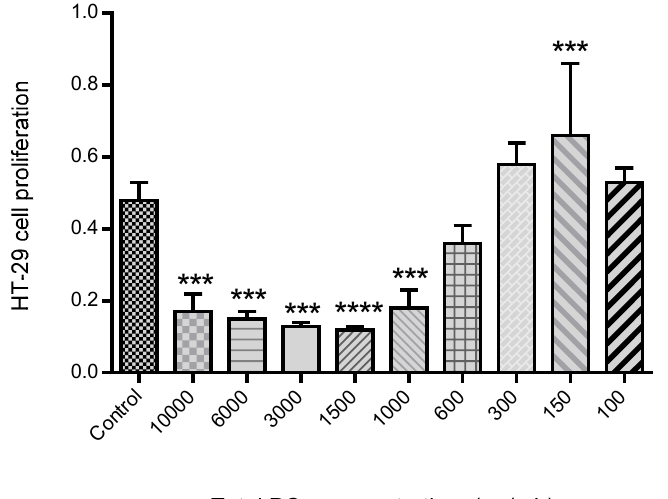
Figure 12. E ff ect of spearmint phenolic extract, at di ff erent concentrations of PCs, on the HT-29 cells Figure 12. Effect of spearmint phenolic extract, at different concentrations of PCs, on the HT-29 cells proliferation. *** p < 0.001 vs. Control; **** p < 0.0001 vs. Control. proliferation. *** p <0.001 vs Control; **** p ˂ 0.0001 vs Control.